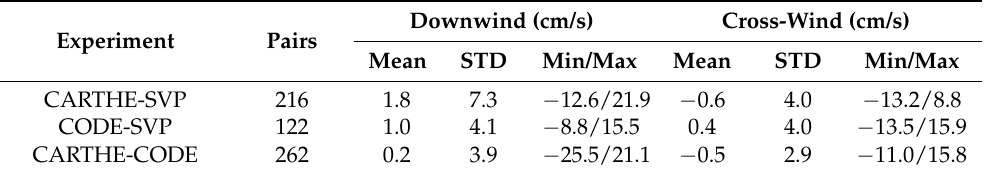
Table 2. Statistics of the difference between pairs of drifters using low-pass filtered drifter and wind